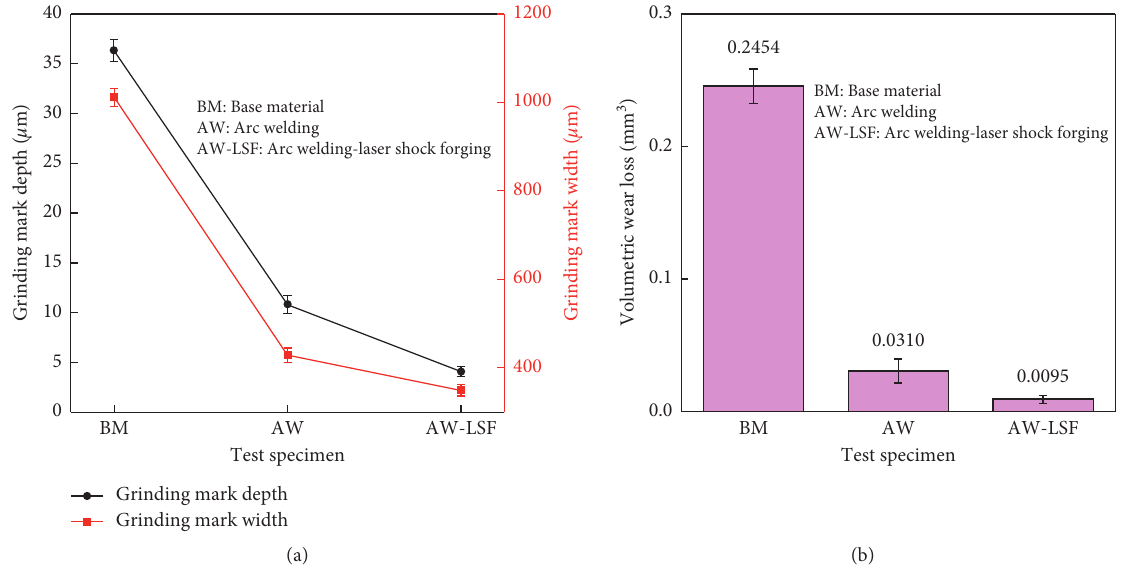
Figure 11: Wear characteristics of the BM, AW cladded layer, and AW-LSF cladded layer: (a) width and depth of the grinding mark and (b) volumetric wear loss. Volumetric wear loss � cross-sectional area of the grinding mark × reciprocating sliding length.